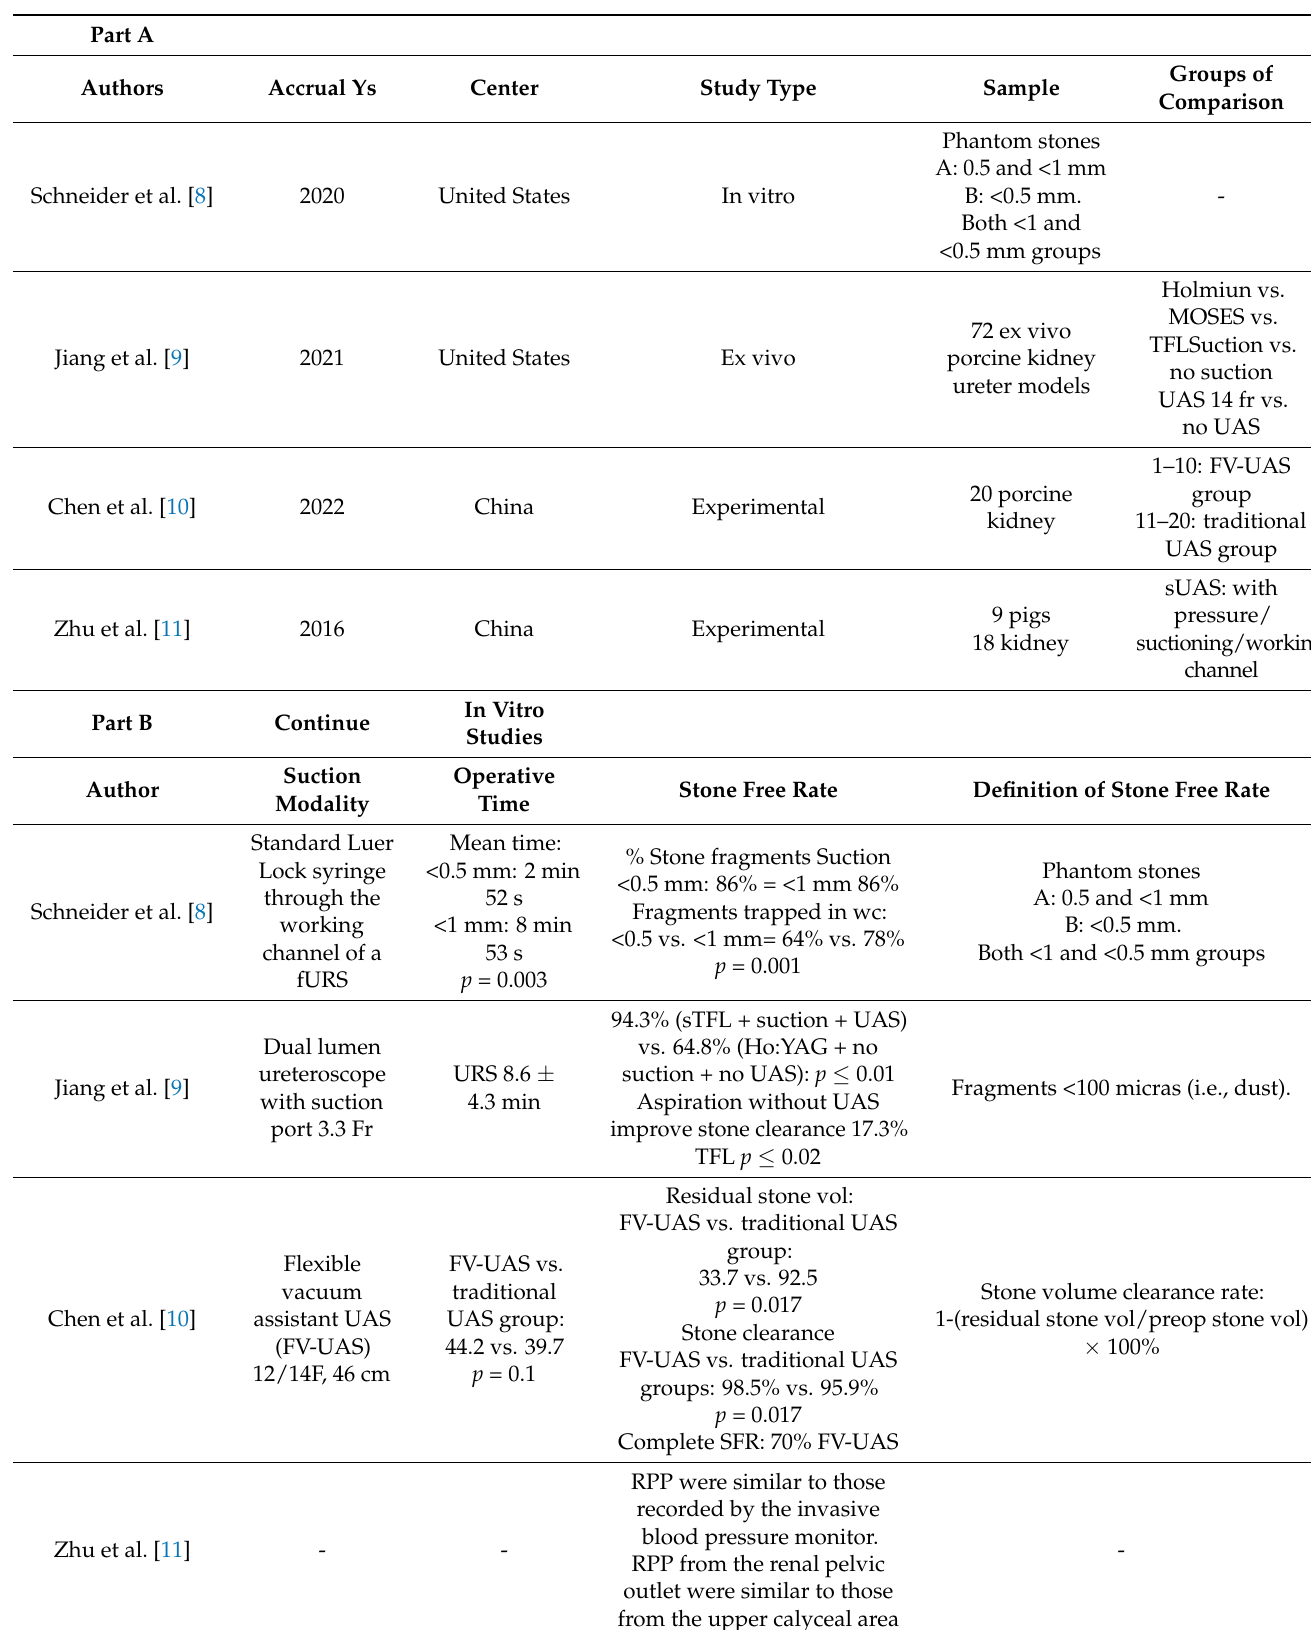
Table 1. In vitro studies